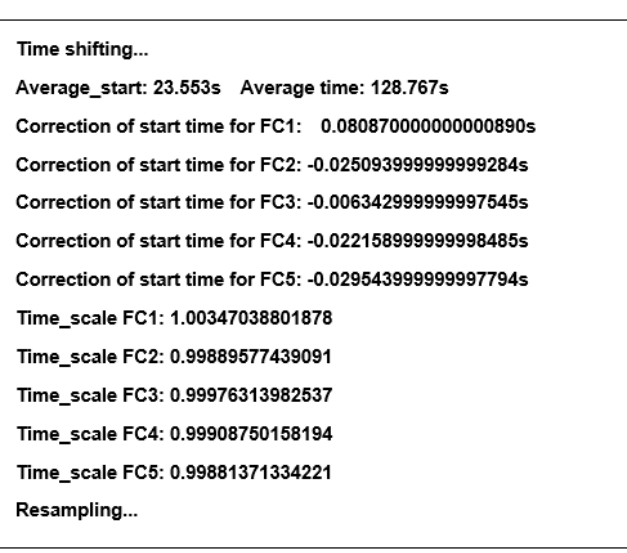
Figure 10. The example output of the synchronization procedure in Python. Table 1. Comparison of selected movement The comparison of different sensors presented above with the proposed sensor is shown in Table 1. Wireless sensors, Xsens Awinda and Noraxon Ultium, are much more